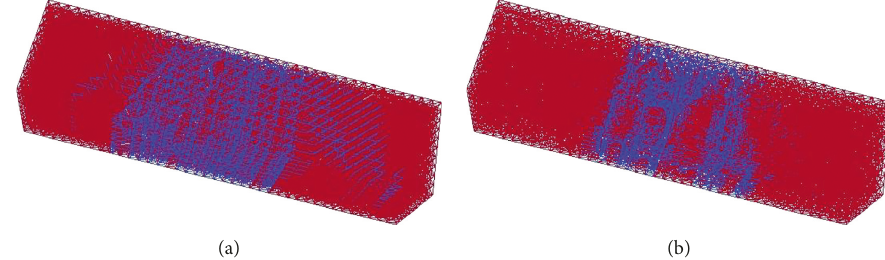
Figure 12: Crack patterns in UHPFRC with different fiber orientation. (a) Aligned distribution and (b) random